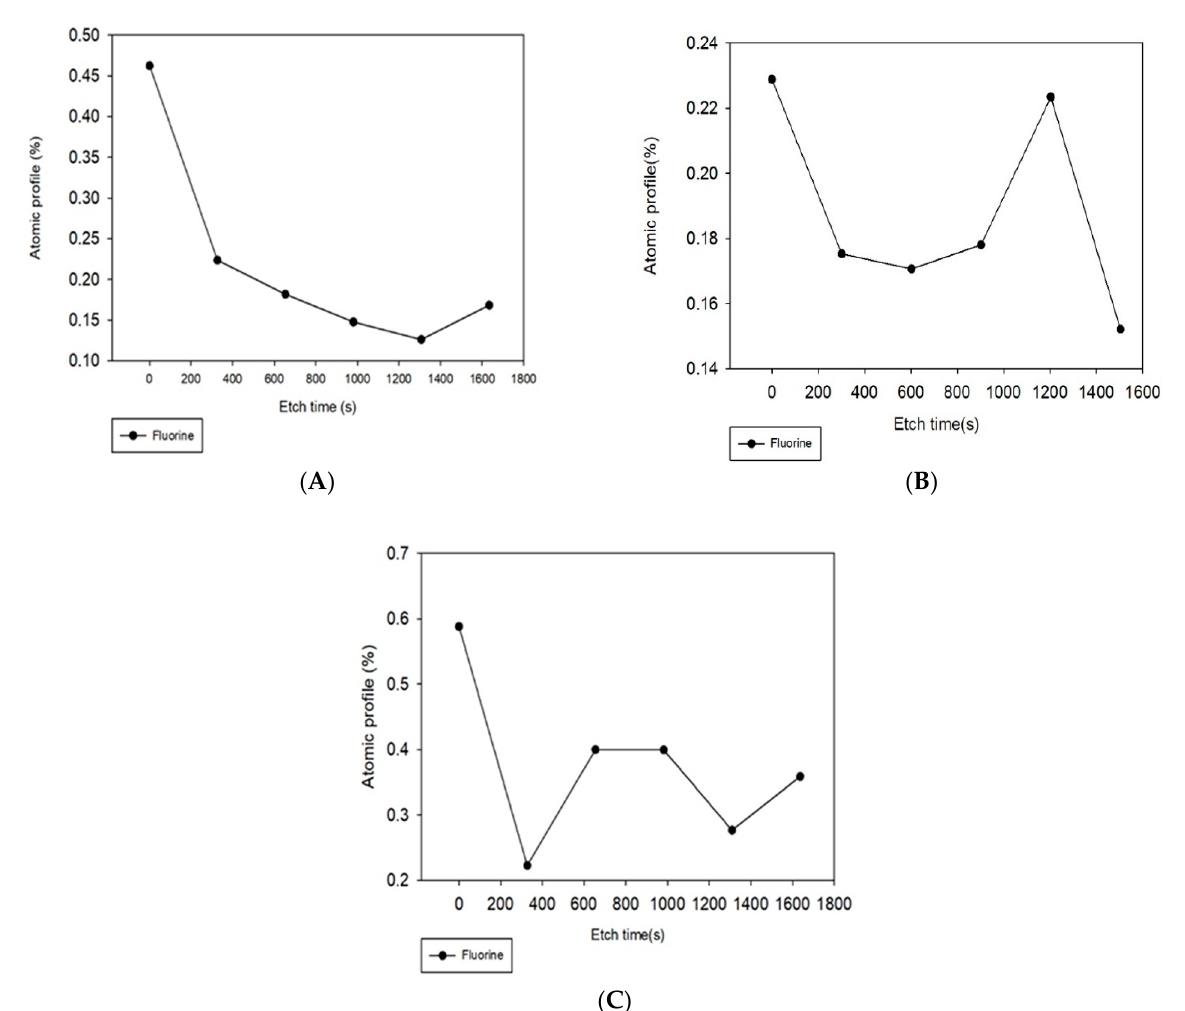
Figure 6. Depth atomic profile showing the percentage of fluorine on the membrane surfaces and within their pores after ( A ) filtration, ( B ) UV irradiation, and ( C ) oxygenation.